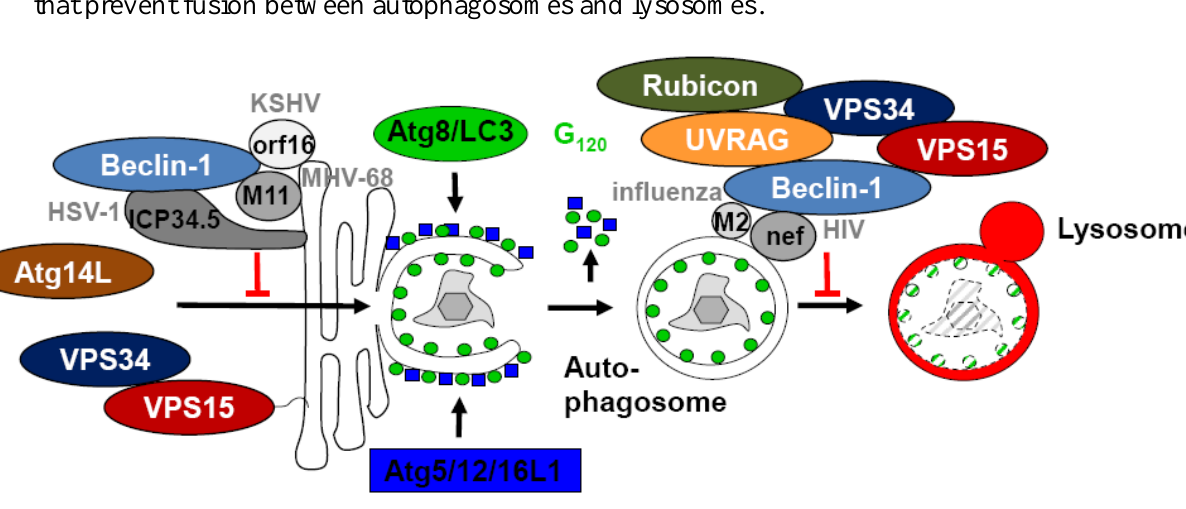
Figure 2. Viral proteins block autophagosome generation and degradation via Beclin-1 binding. KSHV orf16, MHV-68 M11 and HSV-1 ICP34.5 anchor Beclin-1 at